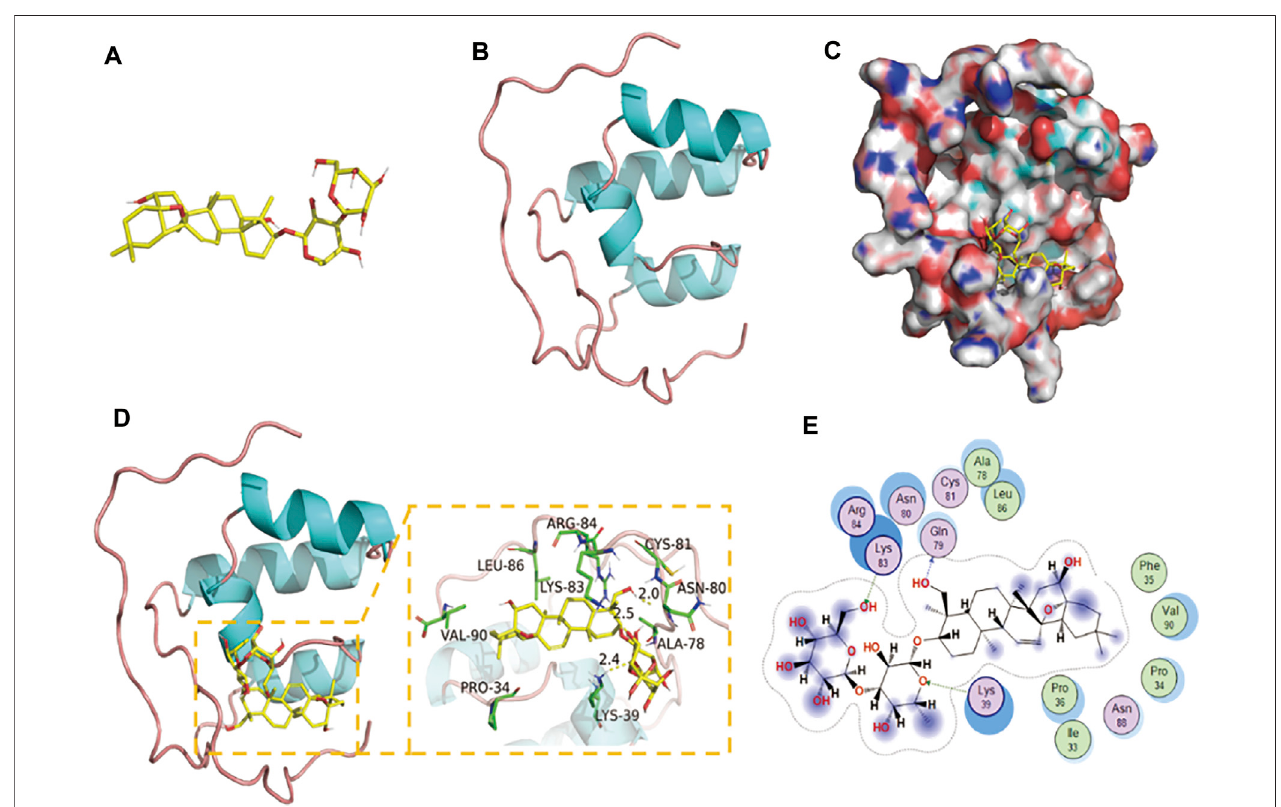
FIGURE 4 | Binding mode of Nrf2 with SSD. (A) The 3D structure of SSD. (B) The 3D structure of Nrf2. (C) The surface of Nrf2 with SSD. (D,E) The detail binding ( Figure 4E ). The hydrogen bond distances are 2.5, 2.4, and 2.0 Å, respectively. In summary, the SSD and Nrf2 protein are well matched and strongly bound, and the complex formed is relatively stable.